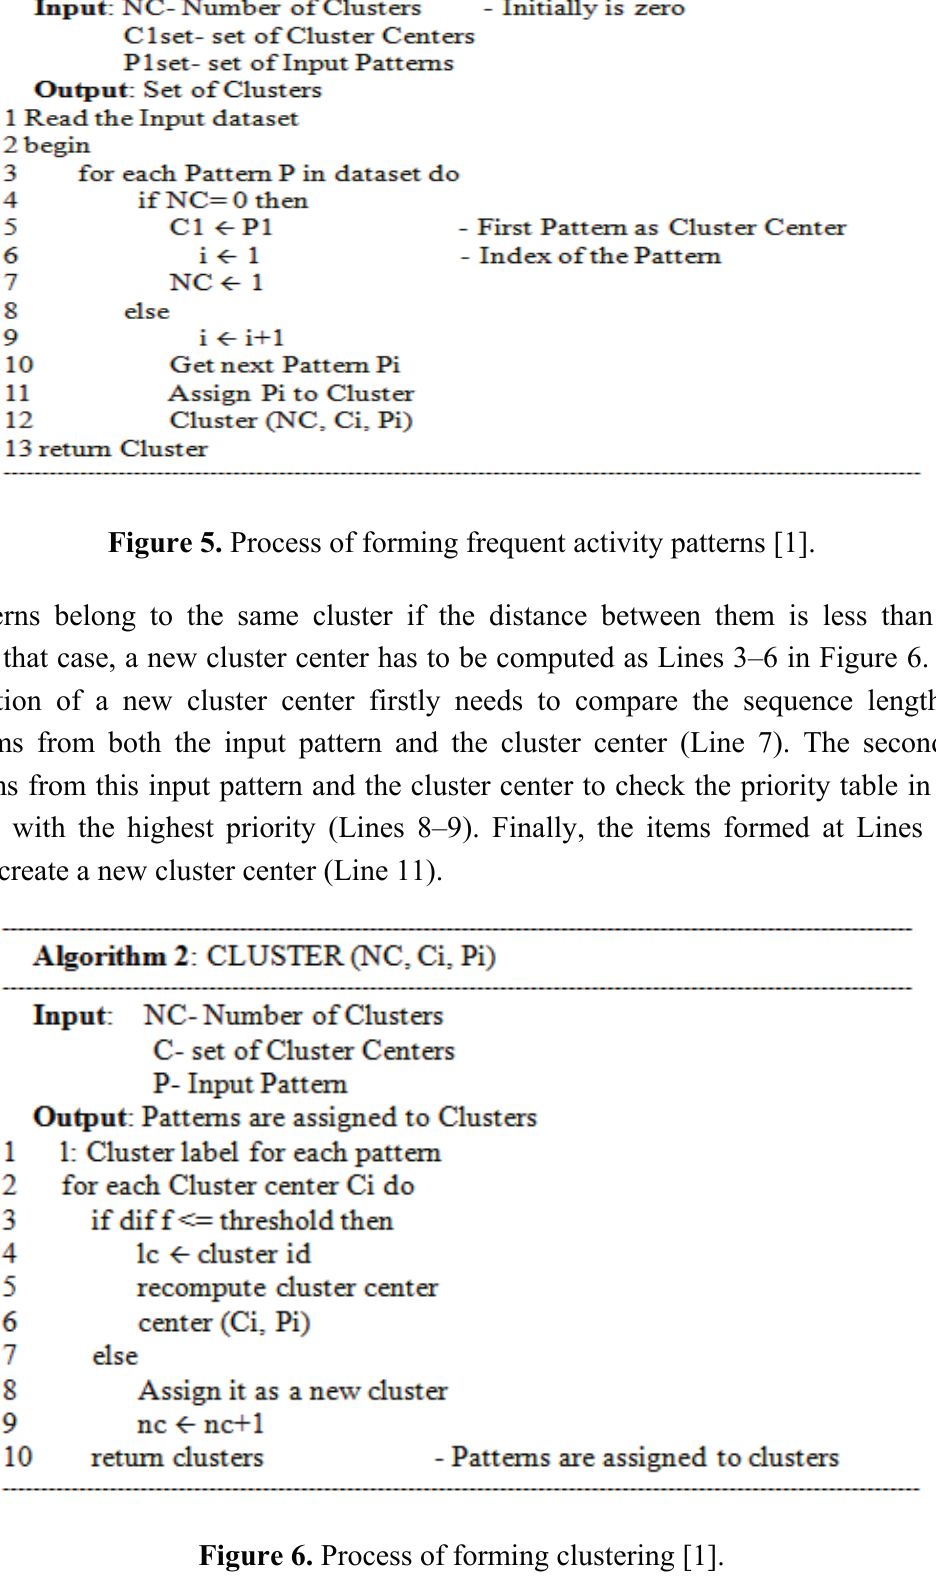
Figure 6. Process of forming clustering